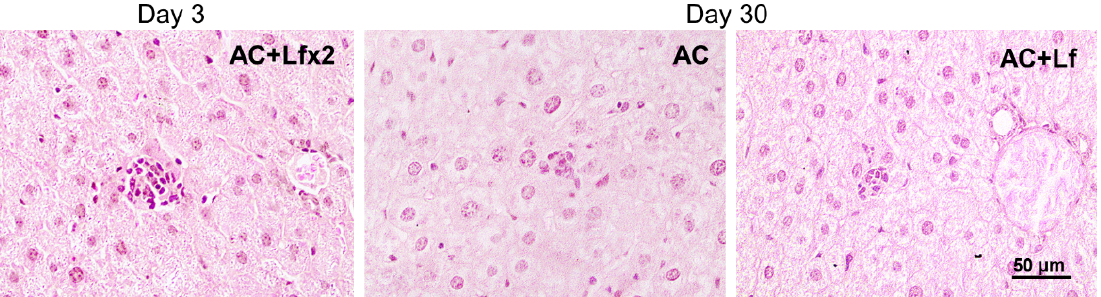
Figure 13. Solitary clusters of mononuclear cells in the liver parenchyma of control mice. Representative photomicrographs of liver sections on days 3 (left) and 30 (middle; right) after sham-irradiation. Groups: AC, AC+Lf, AC+Lf × 2. Hematoxylin and Eosin staining. Scale bar = 50 µ